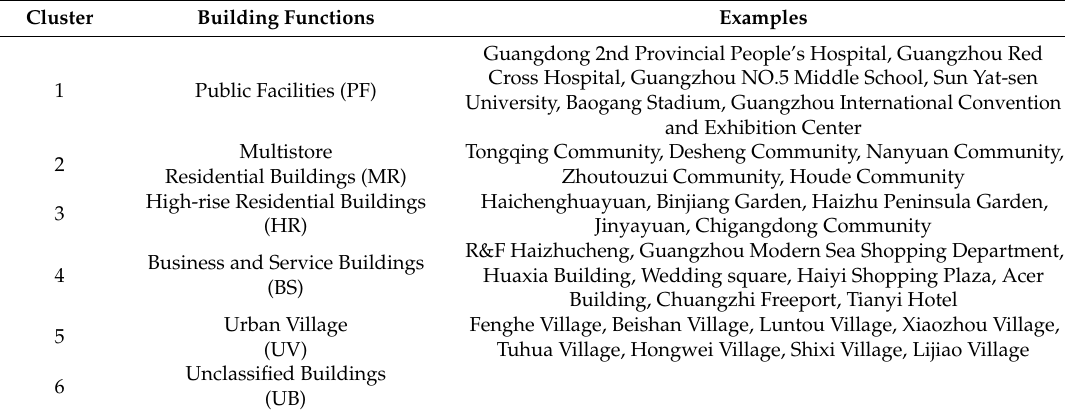
Table 1. Building function identification